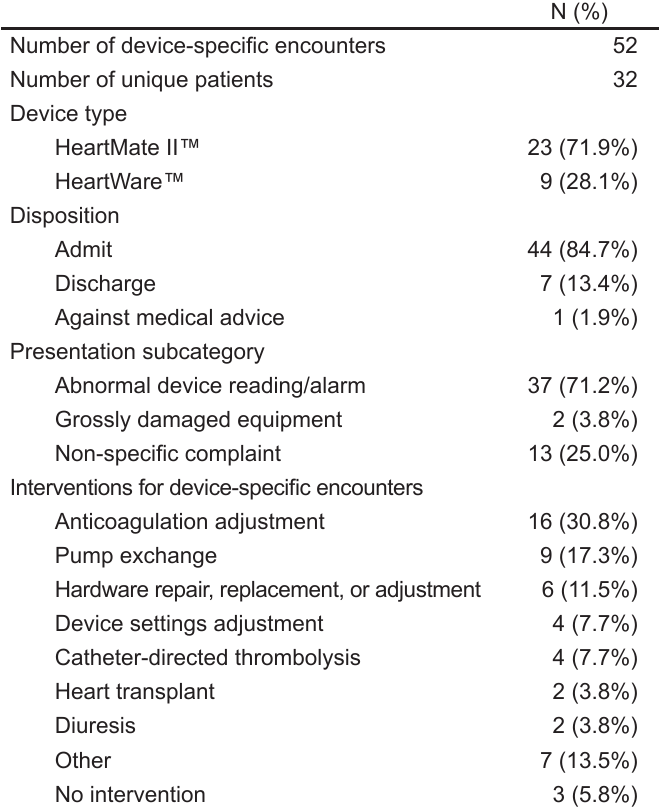
Table. Summary of device-specific encounters and